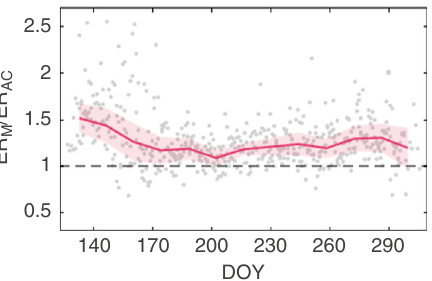
Fig. 2 Daily bias in extrapolated ecosystem respiration estimates. Ratios of daily ecosystem respiration (ER) estimated by a standard fl ux modeling approach (ER M ) and measured by autochambers (ER AC ). Symbols indicate ratios of daily ER M and ER AC for the years 2015 – 2017; the red line represents the block-average (window size = 14 days) with shaded bands indicating ±1 standard error. Horizontal dashed line represents unity of the ratio. The 3-year means of the phenophase transition dates (DOY day of year) are as follows: 143 (spring dormancy → green-up), 187 (green-up → peak season), 218 (peak season → senescence), and 272 (senescence → autumn dormancy).